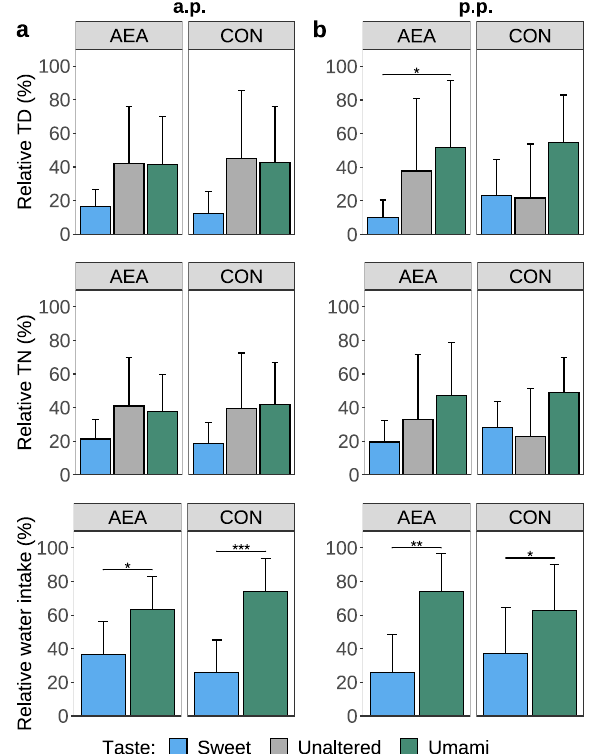
Figure 1. Three-day mean of percentage of total duration (TD) and total number (TN) of events the cow’s head entered the drinking bowl, and water intake of sweet and umami tasting or taste unaltered water during the water preference test ( a ) in the antepartum (a.p.) and ( b ) postpartum (p.p.) period. During the p.p. period, cows were treated intraperitoneally with NaCl (CON, n = 8) or N- arachidonoylethanolamide (AEA, n = 8). The mean of the observed data ± SD is shown for interpretation. * P < 0.05, ** P < 0.01, *** P <